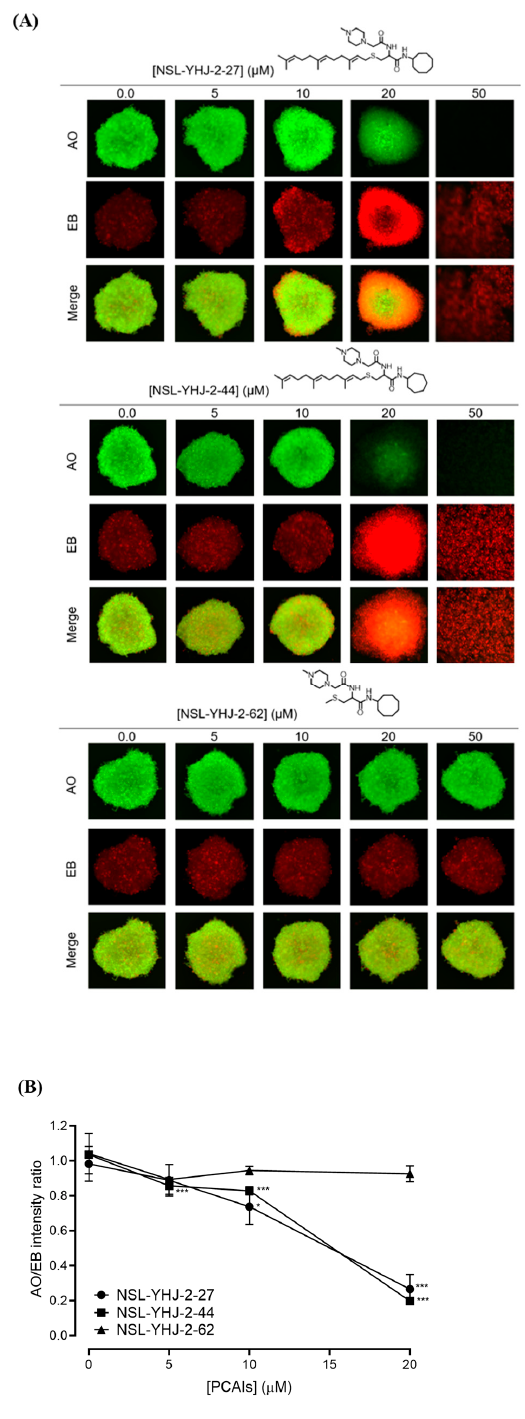
Figure 5. PCAIs induce concentration-dependent cell death in A549 spheroids. ( A ) Cells were seeded in Nunclon Sphera 96-well, U-shaped-bottom microplates and allowed to grow and form compact spheroids overnight. They were then treated with the indicated concentrations of the respective PCAIs for 48 h. The spheroids were stained with AO/EO (5 µ g/mL), and the fluorescent images were taken at 4 × magnification using the Nikon Ti Eclipse microscope. ( B ) Graph showing concentration- dependent decreases in mean AO/EB intensity ratios ( n = 3) indicating the viable to non-viable cells ratios in the spheroids. Statistical significance (* p < 0.05 and *** p < 0.001) was established using one-way ANOVA followed by Dunnett posttest